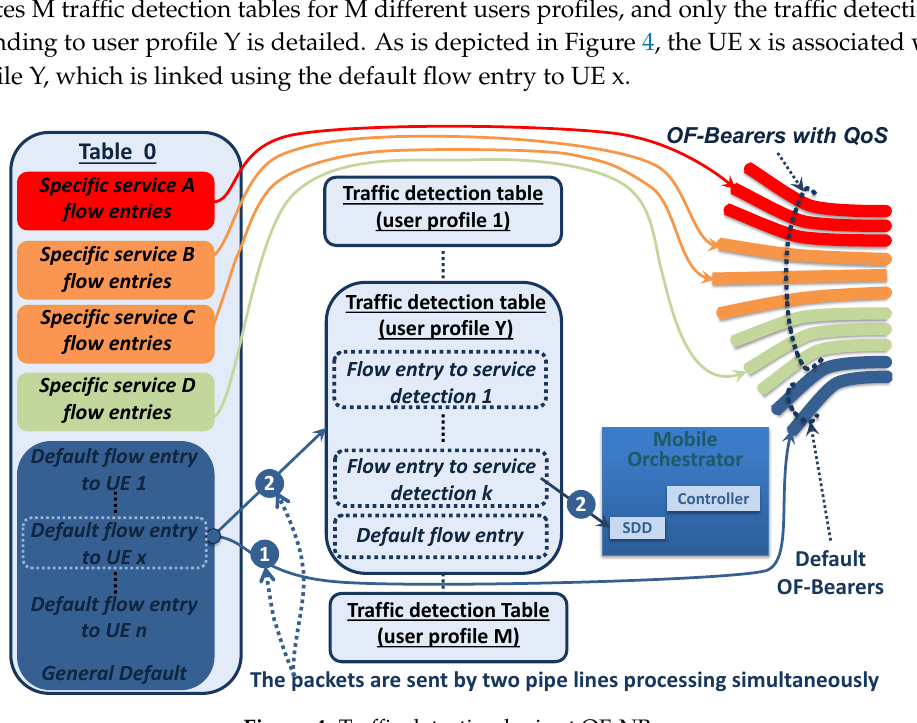
The packets are sent by two pipe lines processing simultaneously Figure 4. Traffic detection logic at